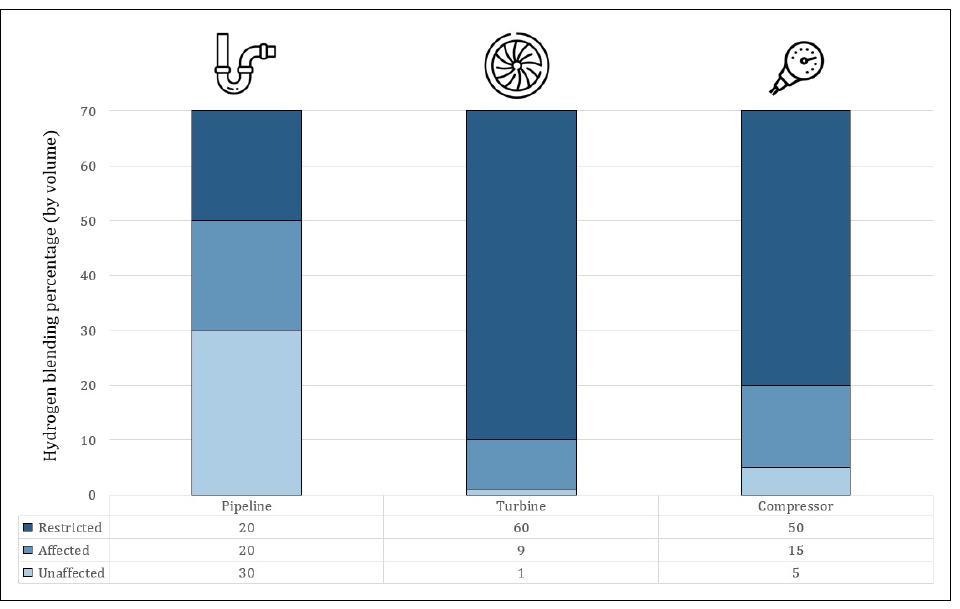
Figure 7. Susceptibility of P2G transmission elements to different volume fractions of hydrogen